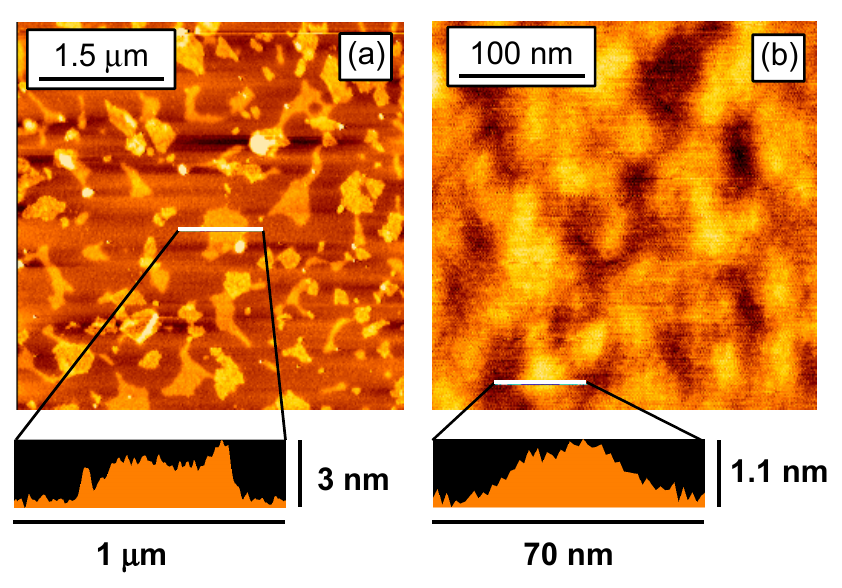
Figure 1. AFM images of ( a ) large-NS and ( b )